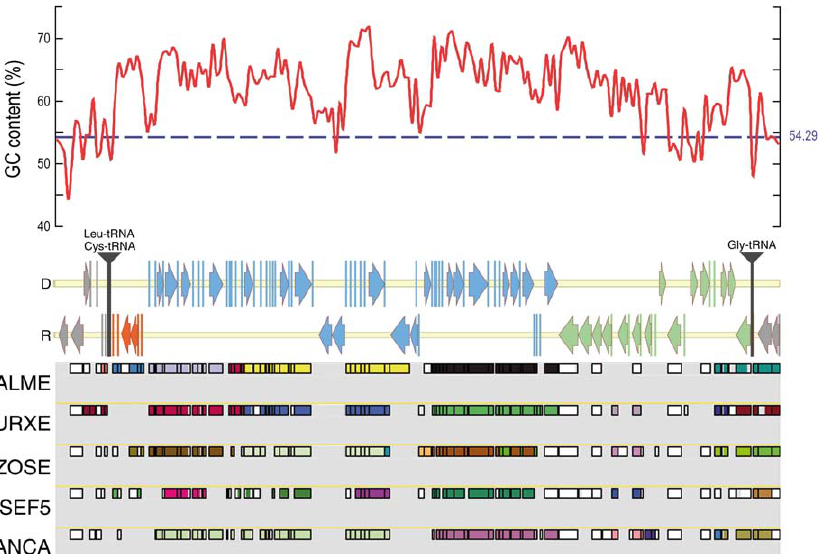
Figure 2. Detailed View of a GC-Rich